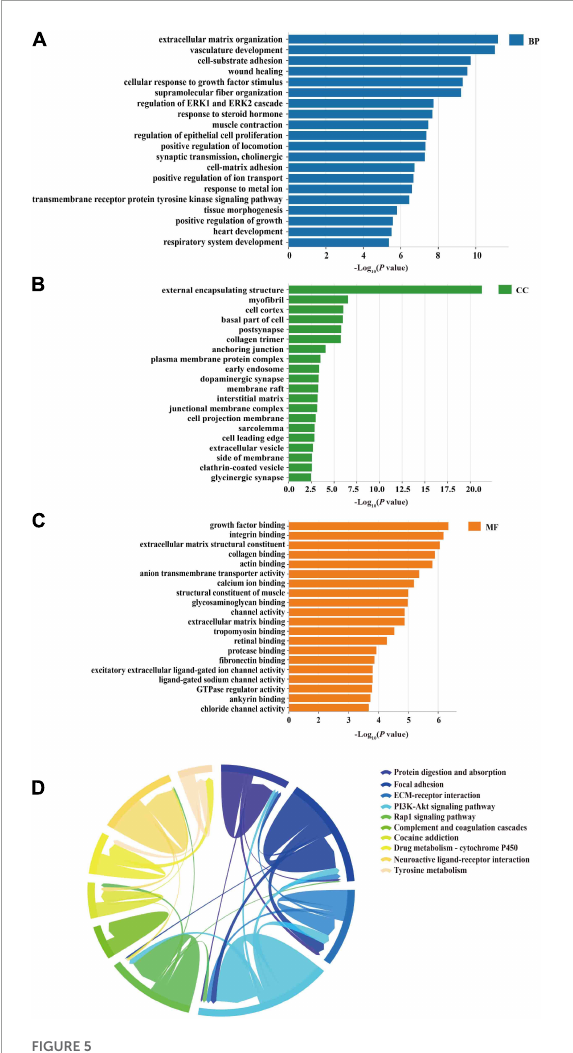
FIGURE5 Gene ontology (GO) and KEGG enrichment analyses. (A) Top 20 GO terms of biological process (BP) as enrichment of 460 miRNA/TF-associated genes, including vasculature development and regulation of ERK1 and ERK2 cascade. (B) Top 20 GO terms of cellular components (CC) from the enrichment analysis of the 460 genes, including myofibril and cell cortex. (C) Bar charts of molecular function (MF) enrichment of the 460 genes, including growth factor binding and integrin binding. (D) Top 10 signaling pathways of KEGG enrichment analysis presented in the form of a Chordal graph, such as the PI3K-Akt signaling pathway and Wnt signaling pathway. Pathways are distinguished by different colors. The top 10 pathways are listed on the right side according to the P -value (from top to bottom in ascending order). Each line represents the association between two pathways. The thicker the line, the more common enriched genes between the two pathways and the stronger the